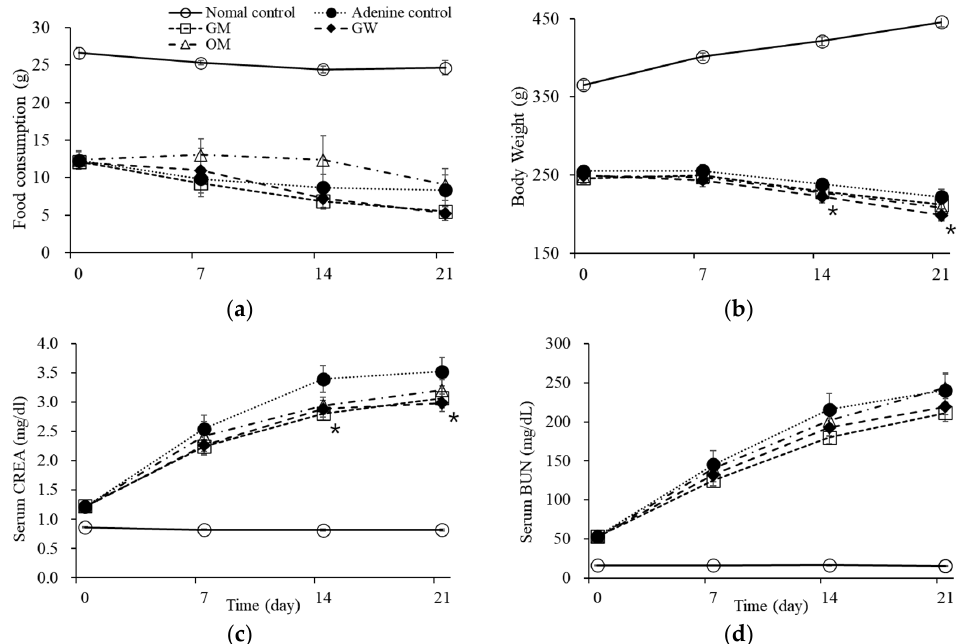
Figure 6. Changes in serum creatinine and BUN level of control and adenine-induced chronic kidney injury SD rats treated with test materials for the experimental period. * p < 0.05; ( a ) Food consumption; ( b ) body weight; ( c ) serum creatinine level; ( d ) serum BUN level; GM: ganghwa mugwort; GW: glasswort; OM, omija.